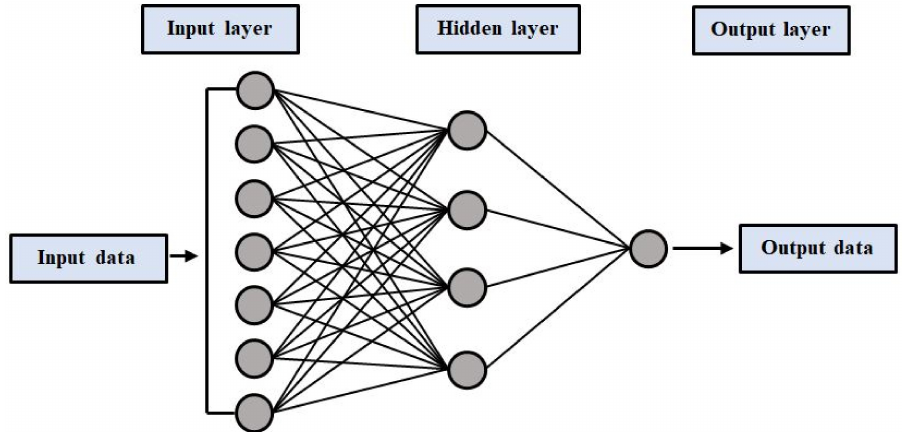
Figure 3. Typical neural network